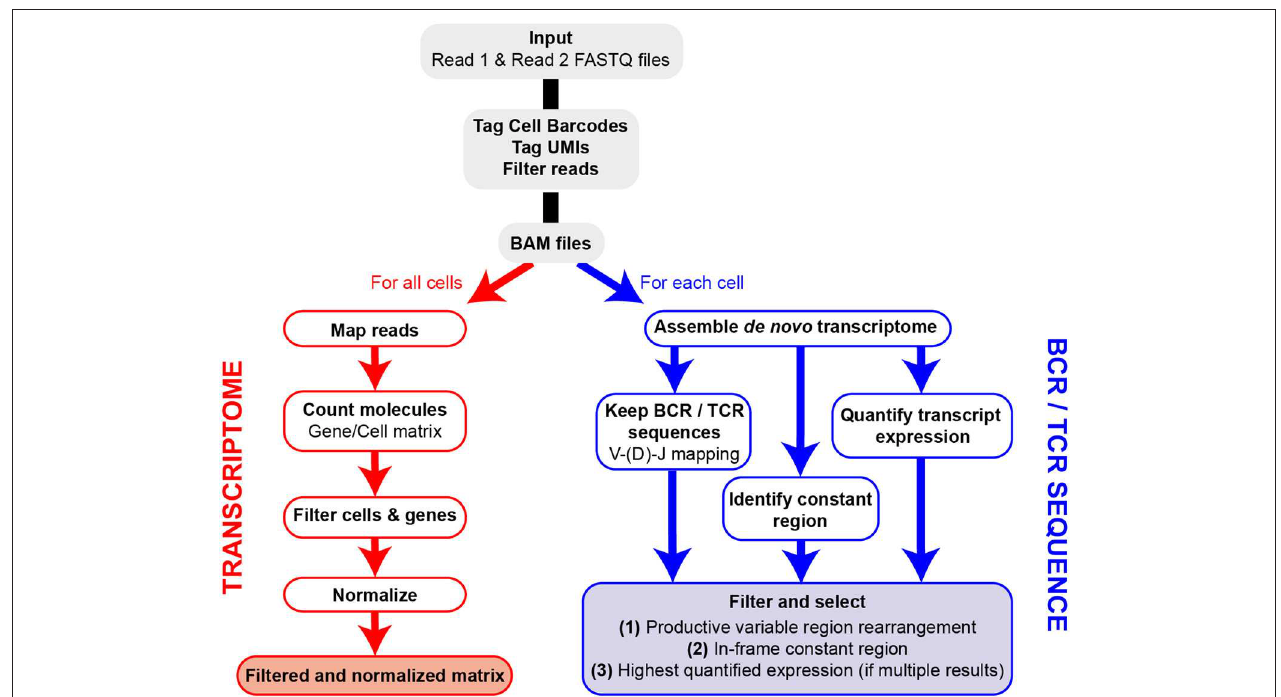
FIGURE 2 | Overview of FB5P-seq bioinformatics workflow. Major steps of the bioinformatics pipeline starting from Read1 and Read2 FASTQ files for the generation of single-cell gene expression matrices and BCR or TCR repertoire sequences.